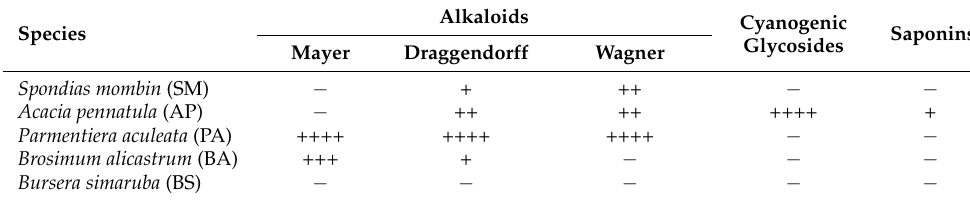
Table 2. Secondary metabolite content of tree species from southern Mexico.